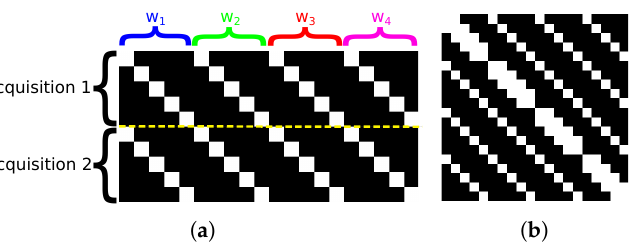
Figure 2. Graphical representations of matrices ( a ) H and ( b ) A matrices in the OR model, with N = 2, C = 5 and W = 4. The white dots represent the non-zero entries. Here, the DMD is entirely in transmission mode to depict all the possible non-zero entries. The yellow dashed line separates the acquisitions.